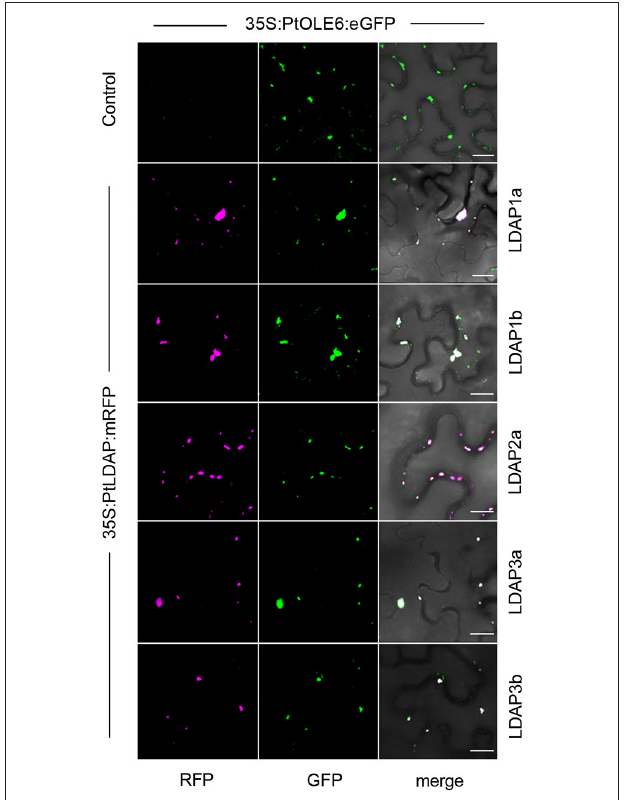
FIGURE 7 | Localization of Lipid Droplet Associated Proteins (LDAPs) at lipid bodies in N. benthamiana . Representative confocal laser scanning microscopy images of leaf epidermal cells transiently co-expressing eGFP-tagged OLE6 and corresponding mRFP-tagged LDAPs (magenta). Single optical sections of RFP, GFP, and the merged images are shown for each set of experiments. Bars 50 µ